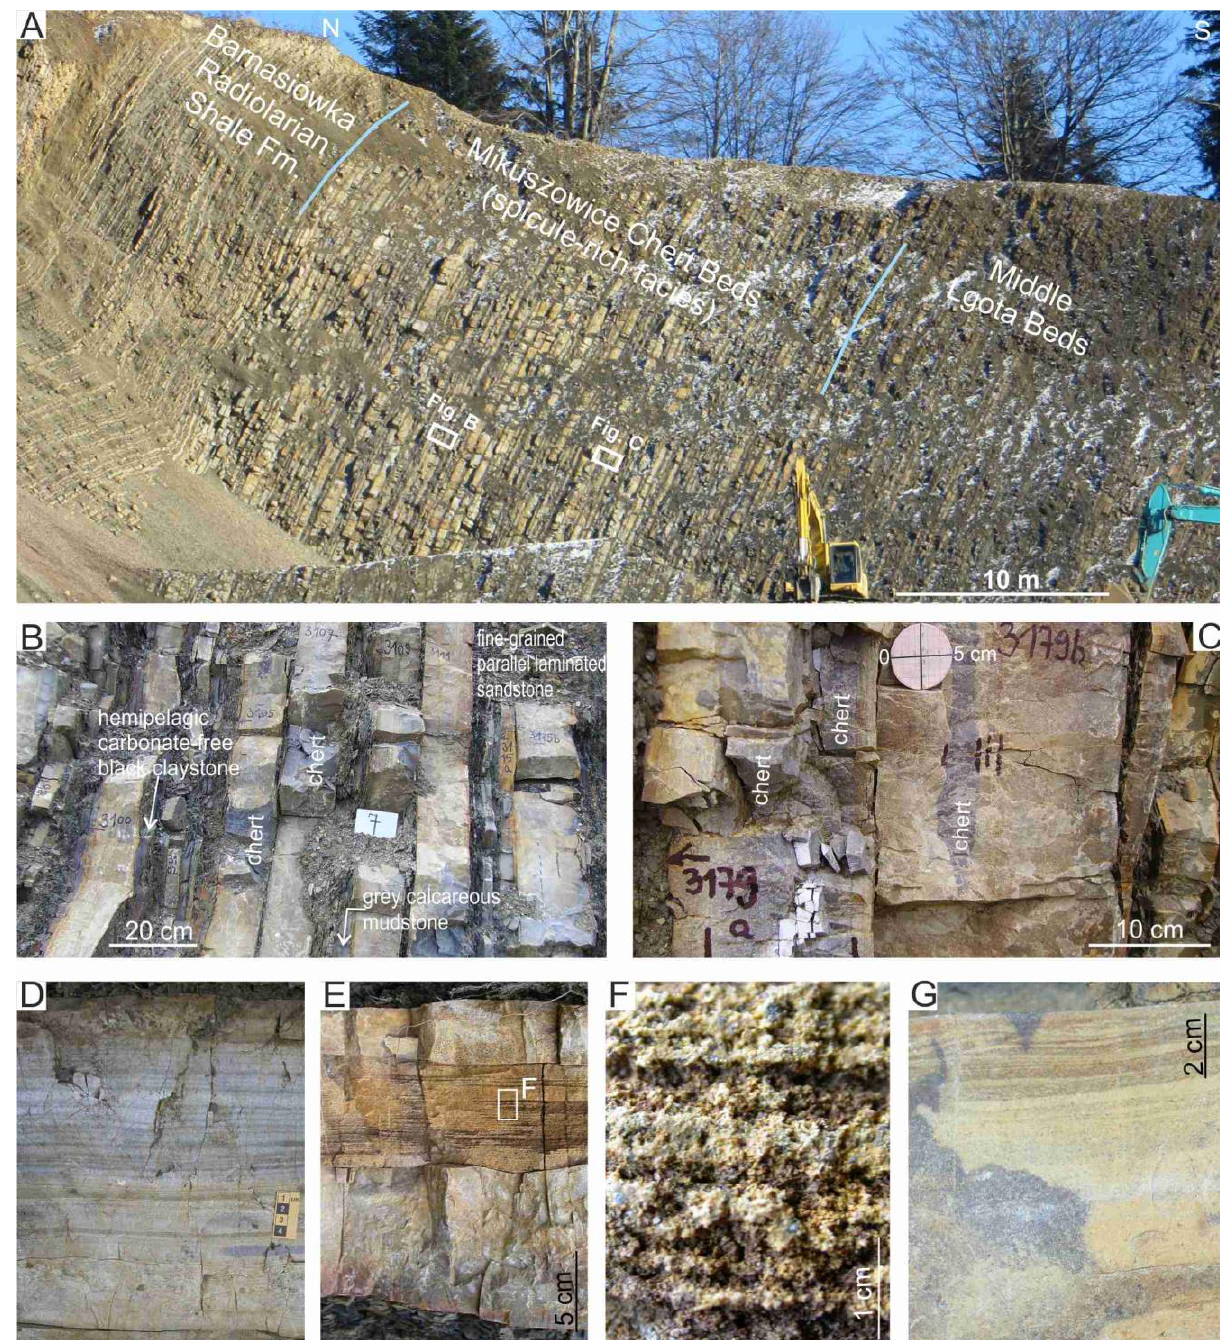
Figure 3. ( A ) Upper Albian – upper Cenomanian flysch sediments of the Silesian Nappe outcropped in the Barnasiówka-Jasienica quarry, Polish part of the Outer Carpathians (photograph taken in December, 2020). ( B , C ) Examples of lower Cenomanian turbidite and hemipelagic facies belonging to the Mikuszowice Chert Beds; note numerous occurrence of cherts in fine- to medium-grained sandstone layers; silica originating mostly from sponge spicules. ( D – G ) Most of the sandstone layers of the MCB contain T bd intervals of Bouma sequence, occasionally — T bc intervals ( G ).